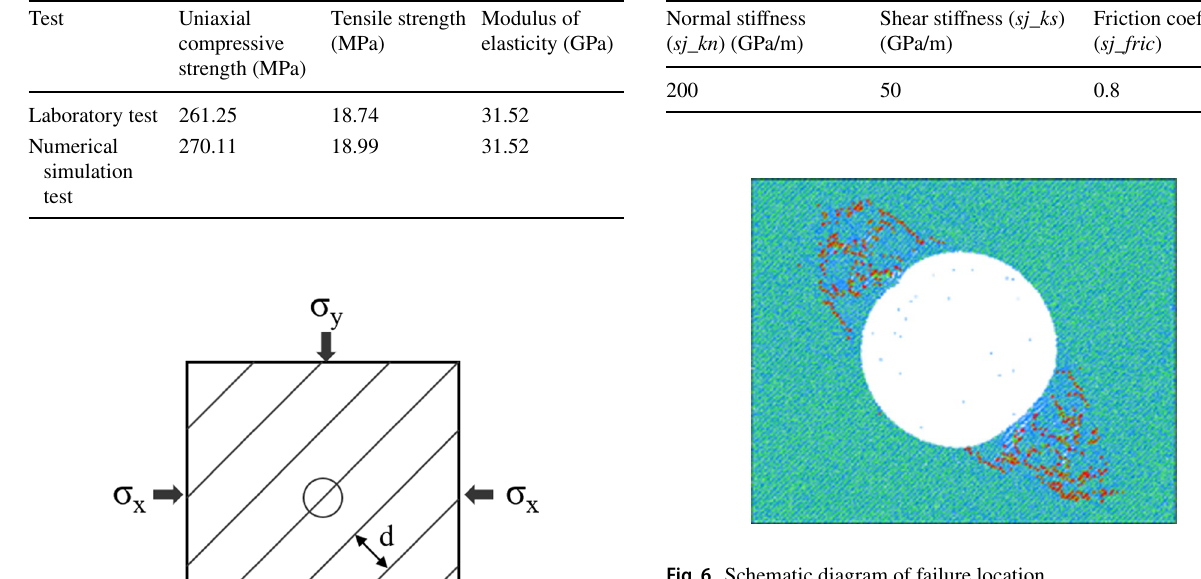
Fig. 6 Schematic diagram of failure location